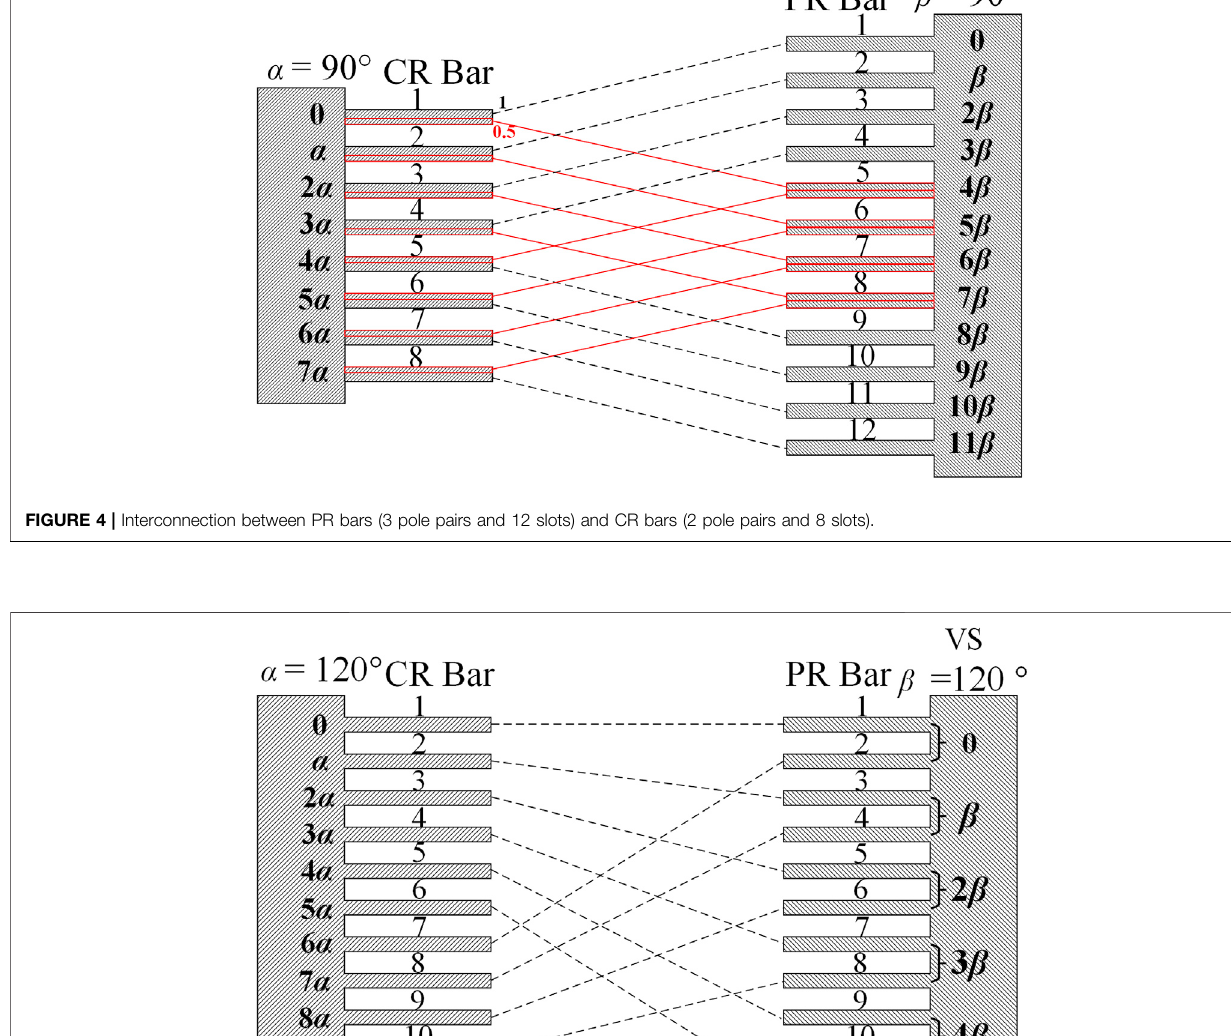
Frontiers in Energy Research |